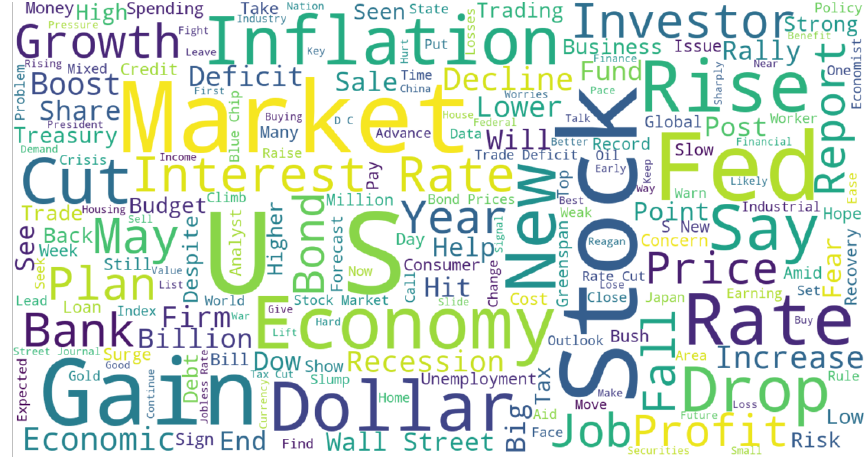
Figure 9. WordCloud for news